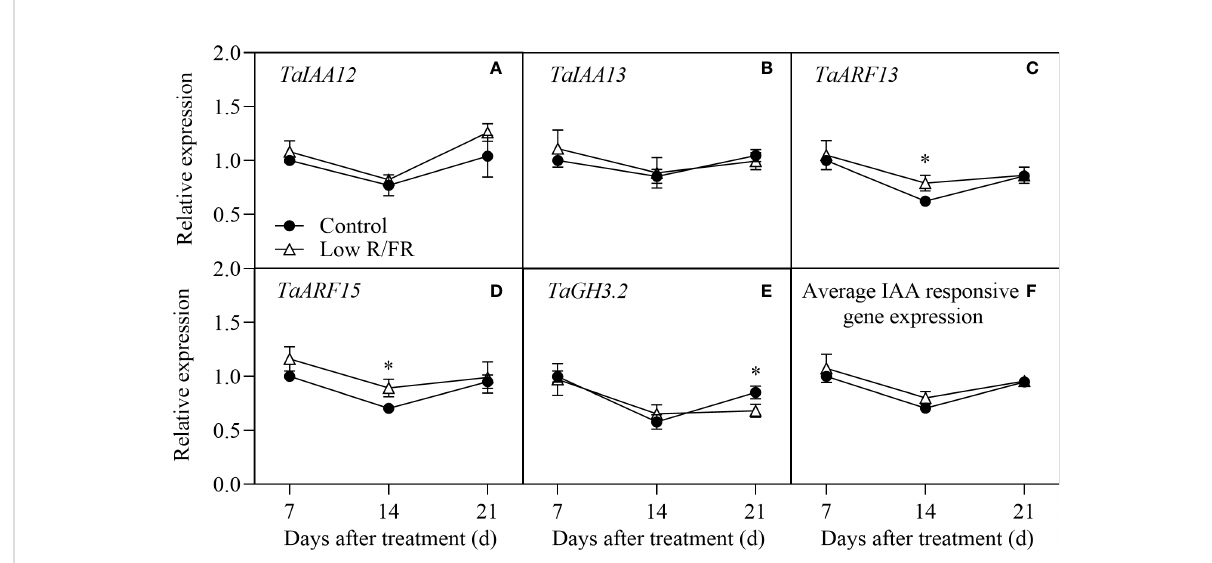
FIGURE 4 Expression of IAA-responsive genes in tiller nodes under control and low R/FR conditions. Relative transcript levels of TaIAA12 (A) , TaIAA13 (B) , TaARF13 (C) , TaARF15 (D) , TaGH3.2 (E) , and average positive normalized expression (F) in tiller nodes treated for 7, 14 and 21 d. Data are the means of three biological replicates ± SE, and the asterisk denotes a statistically remarkable difference ( P < 0.05) between treated and control